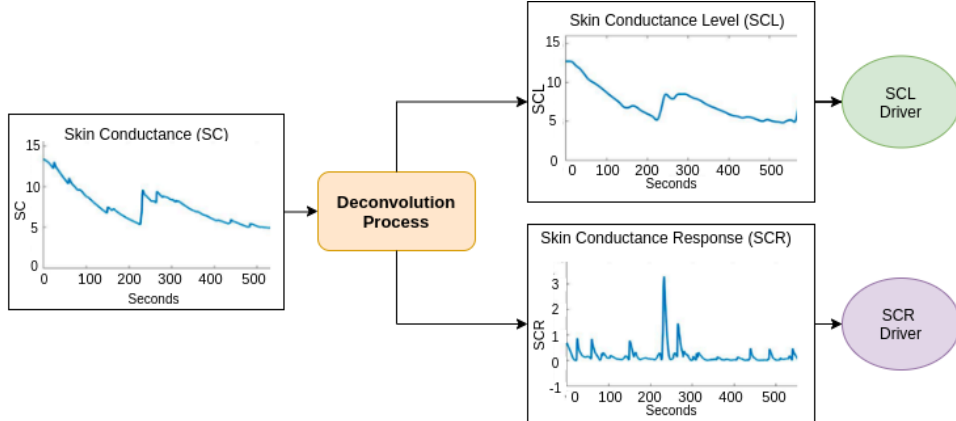
Figure 6. Flowchart of the deconvolution